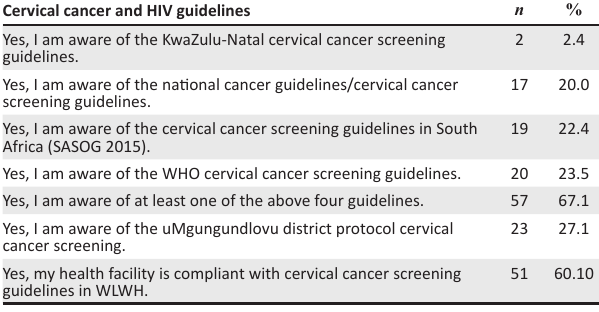
TABLE 1: Healthcare workers’ designation and experience or training in different levels of care. Variables